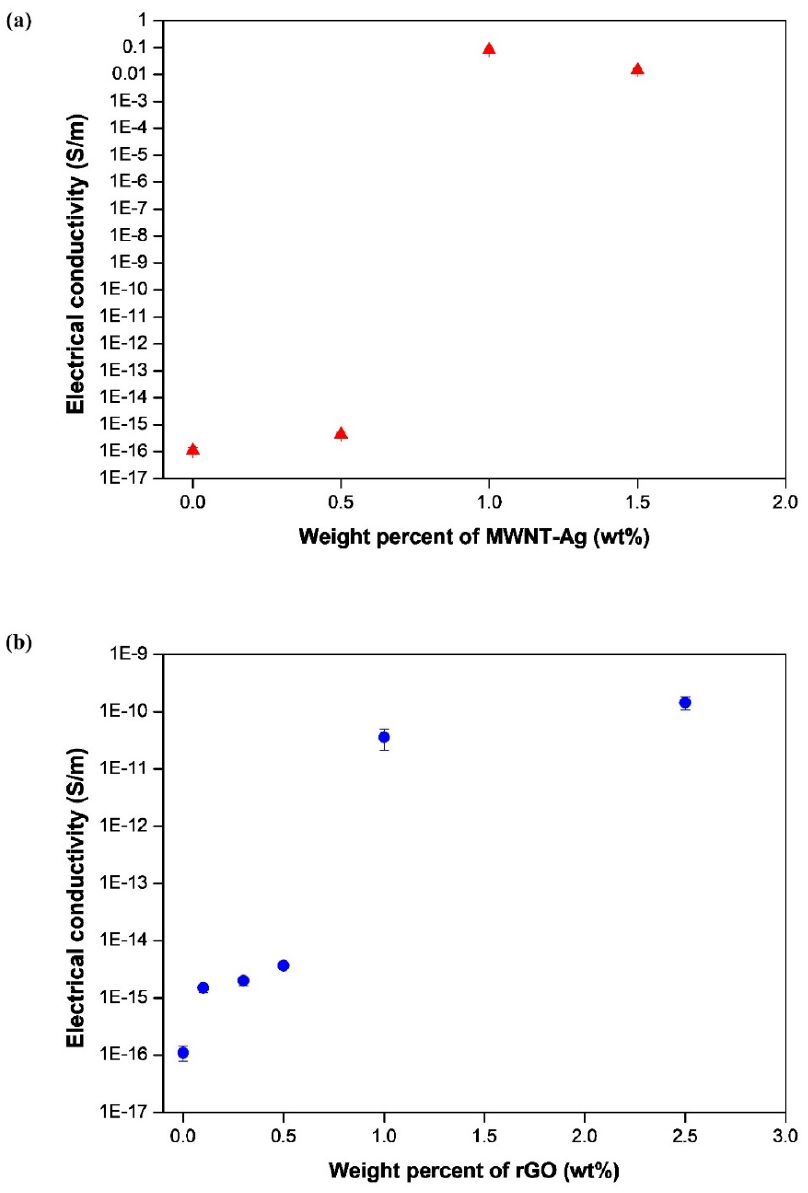
Figure 9. Electrical conductivity of: ( a ) PLA/MWNT-Ag; ( b ) PLA/rGO films.